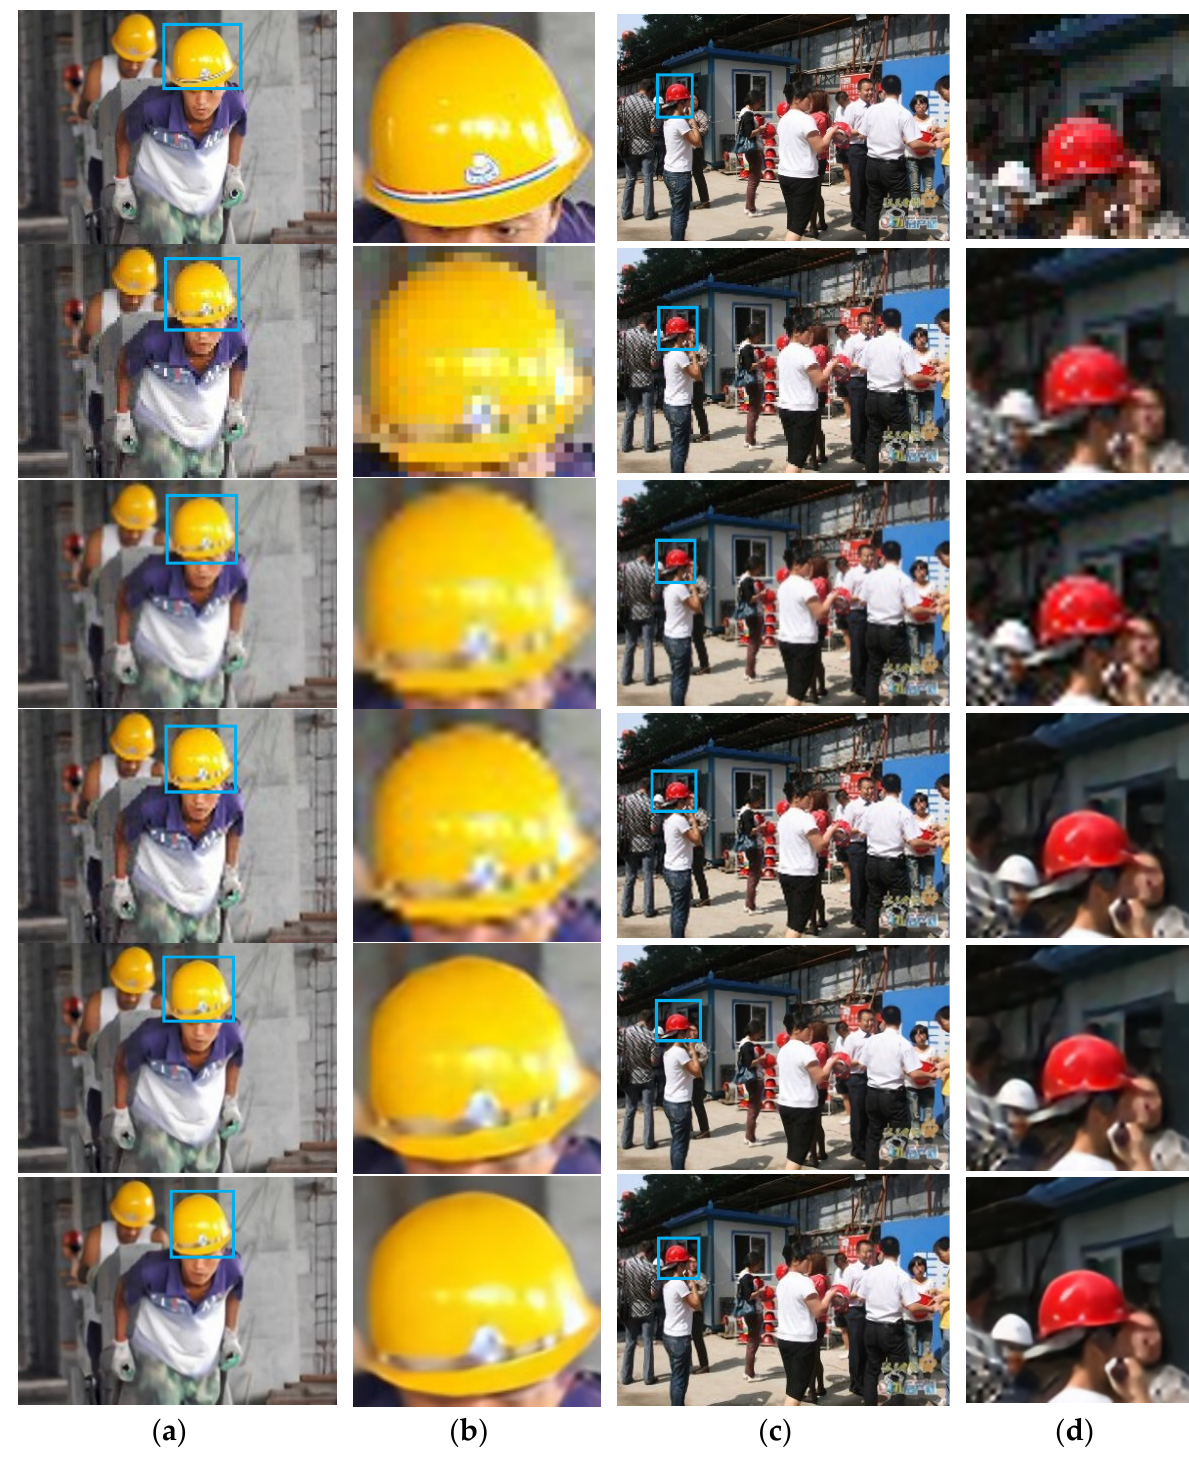
Figure 4. The comparison of the images produced by different SR method. From left to right, columns ( a , c ) indicate the complete images, columns ( b , d ) indicate the zoom-in regions defined by the blue bounding boxes. From the first row to the last row: original high-resolution image, images achieved via nearest neighbor interpolation, images achieved via bilinear interpolation, images achieved via bicubic interpolation, images achieved via DRN, images achieved via the proposed SR module.